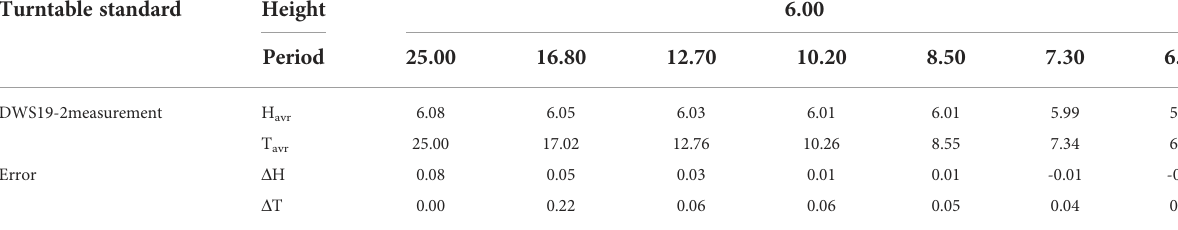
TABLE 4 Measurement at a height of 6 m (height unit: m; period unit: